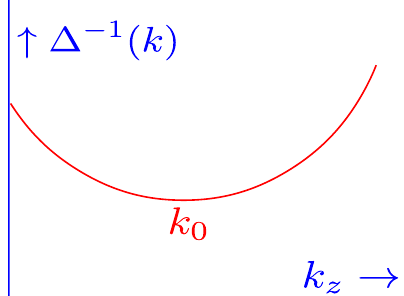
Figure 2. The dispersion relation for the Lagrangian of Equation (2) in the symmetric phase, where Z < 0 and m 2 >